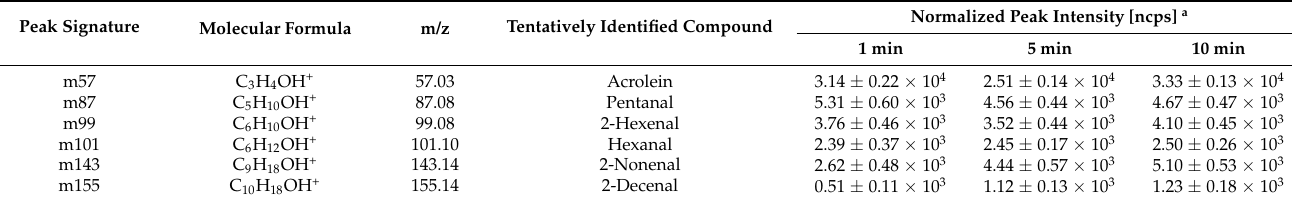
Table 1. Intensity (ncps) of selected SOPs (secondary oxidation products) of rapeseed oil in the first, fifth and tenth minute of frying .